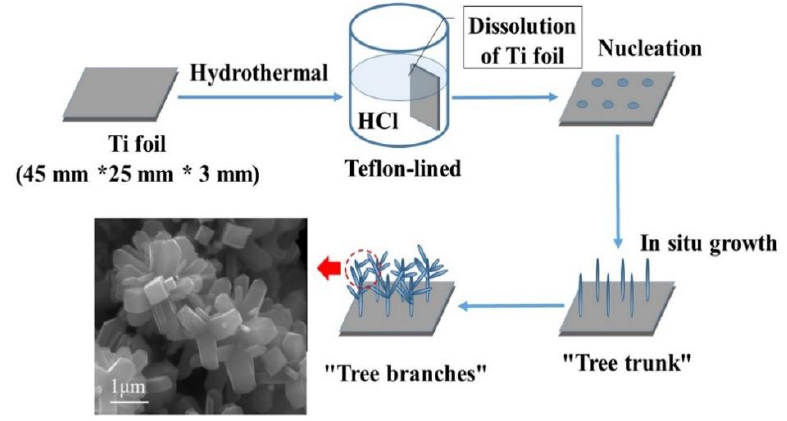
Figure 1. Preparation processes of TiO 2 nanorods.